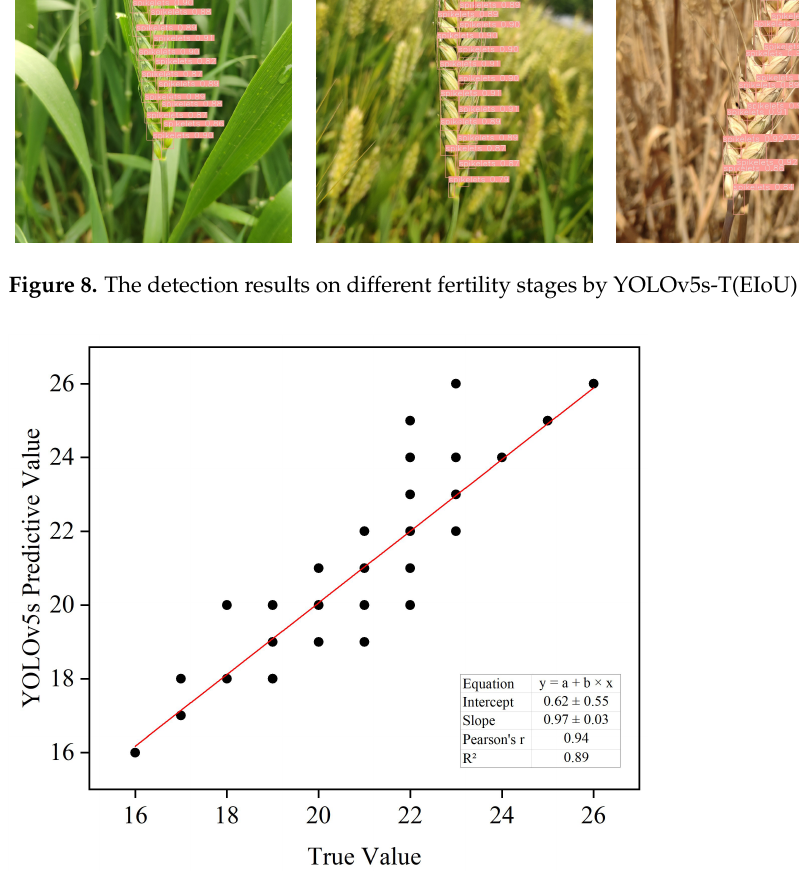
Figure 9. Statistical correlation between the predicted and true values of YOLOv5s.